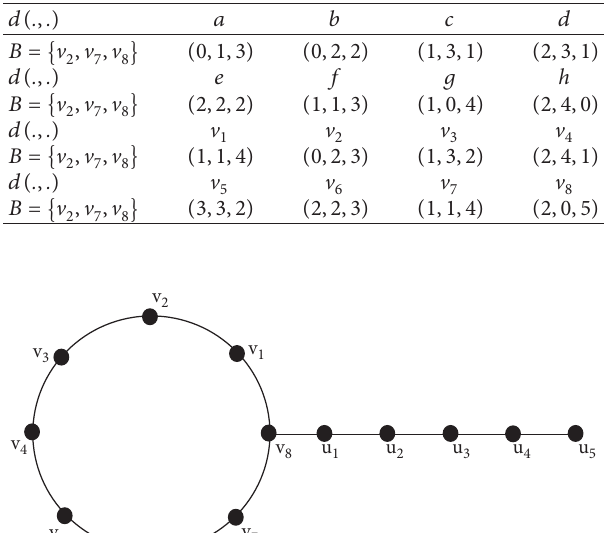
Figure 2: Dragon graph T